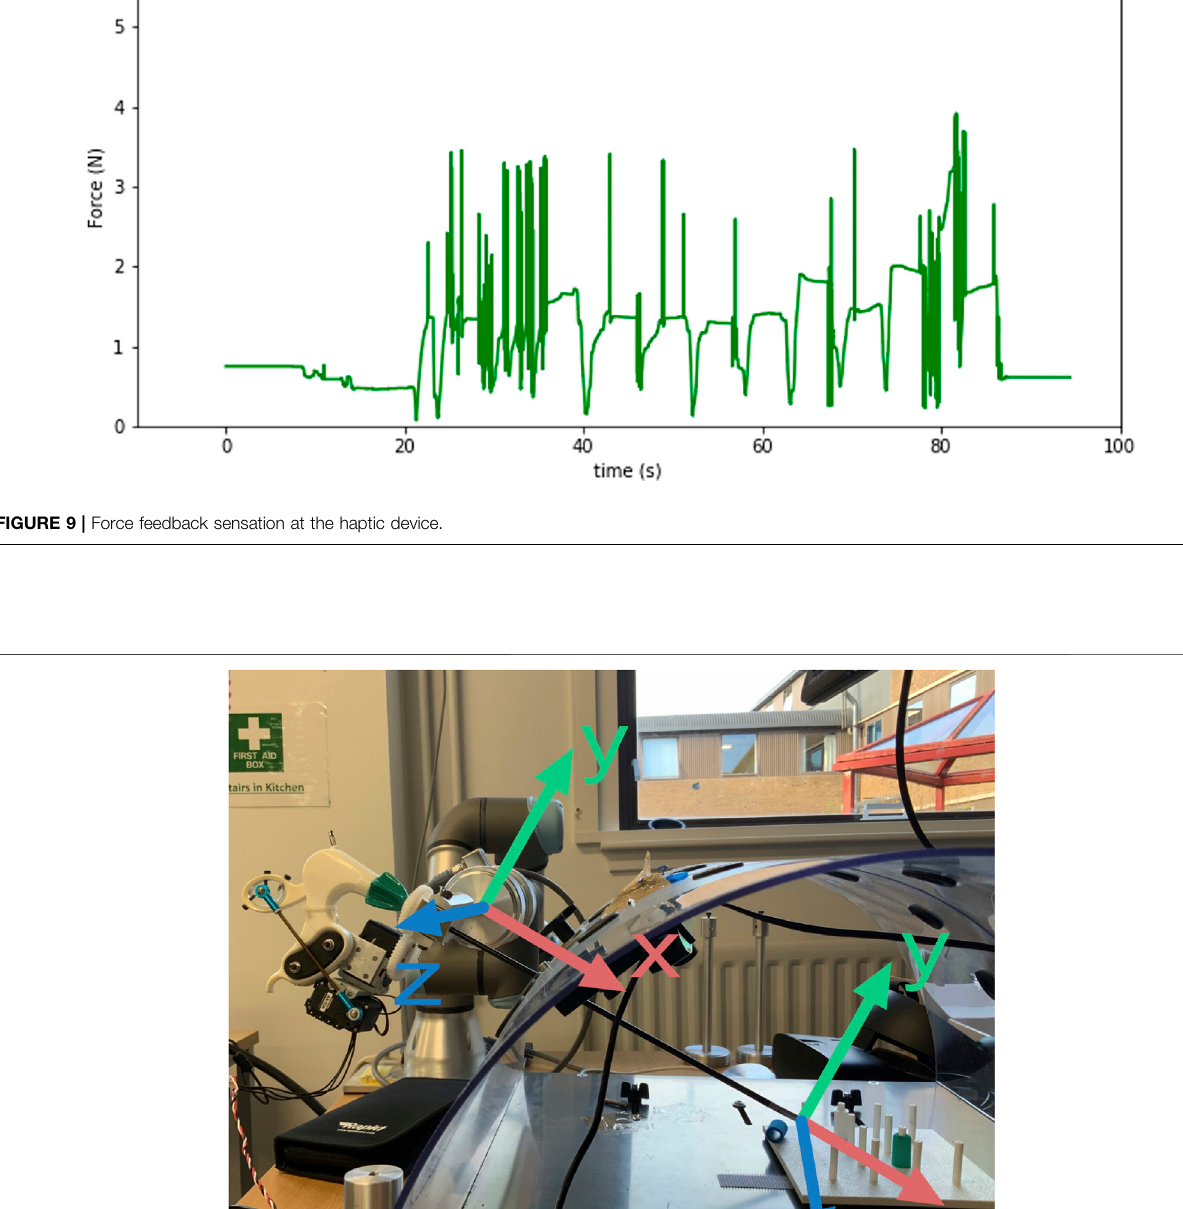
Frontiers in Robotics and AI |